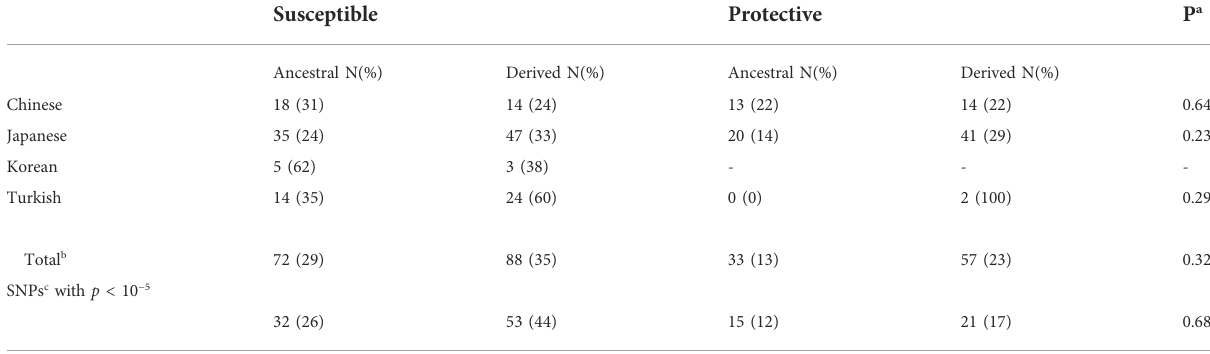
TABLE 1 Comparison of ancestral and derived allele status versus population distribution of BD associated SNPs with respect to their effect on BD.